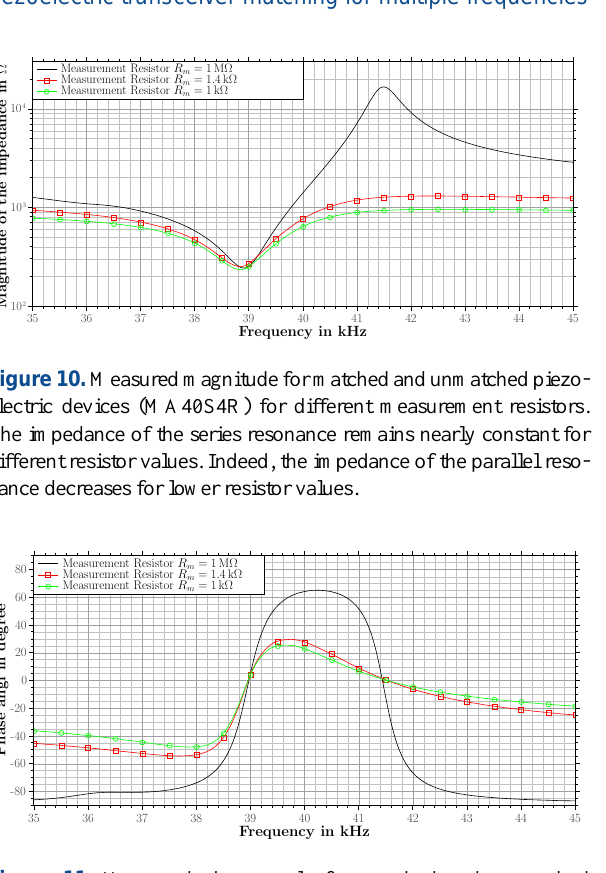
Figure 11. Measured phase angle for matched and unmatched piezoelectric devices (MA40S4R) for different measurement resis- tors. The phase angle for the series resonance remains constant for different resistor values at about 0 ◦ . However, the phase angle for the parallel resonance changes from 60 ◦ for R m = 1M (cid:127) to 14 ◦ for R m = 1M (cid:127)